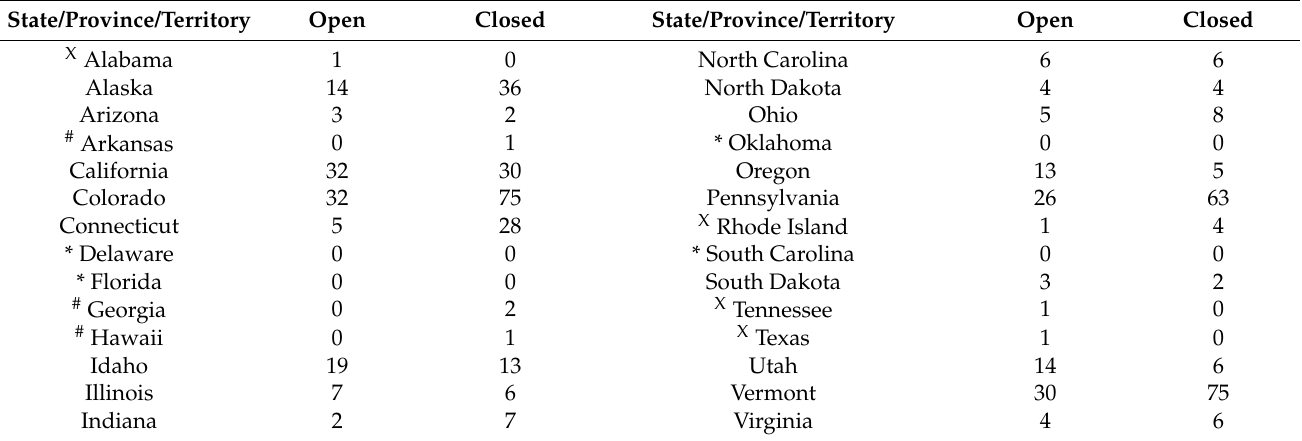
Table 2. State/Province/Territory of open and closed resorts (between